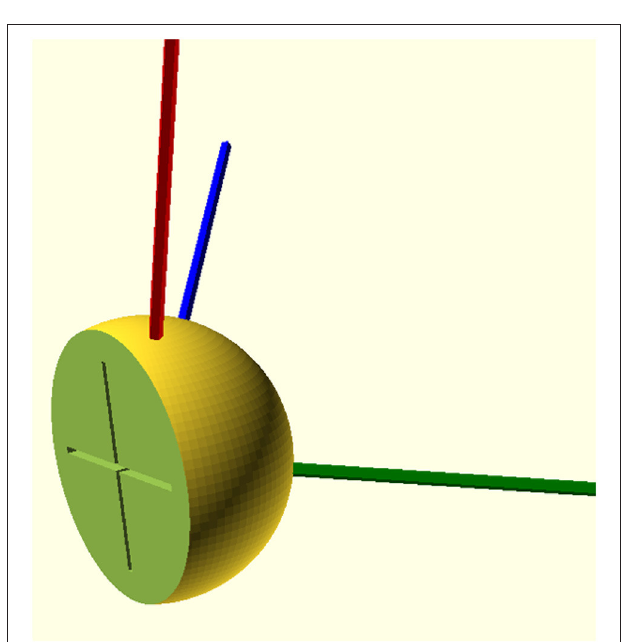
FIGURE 6 | Solid model of the human semicircular canal spatial attitude. Red, blue, and green represent the normal vectors of the right lateral semicircular canal plane, posterior semicircular canal plane, and superior semicircular canal plane, respectively. The medial cross represents the Y-axis and